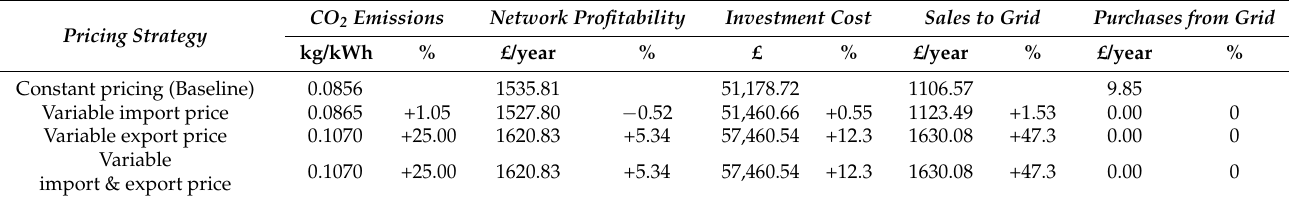
Table 8. Comparison of economic and environmental impacts for the Unset network